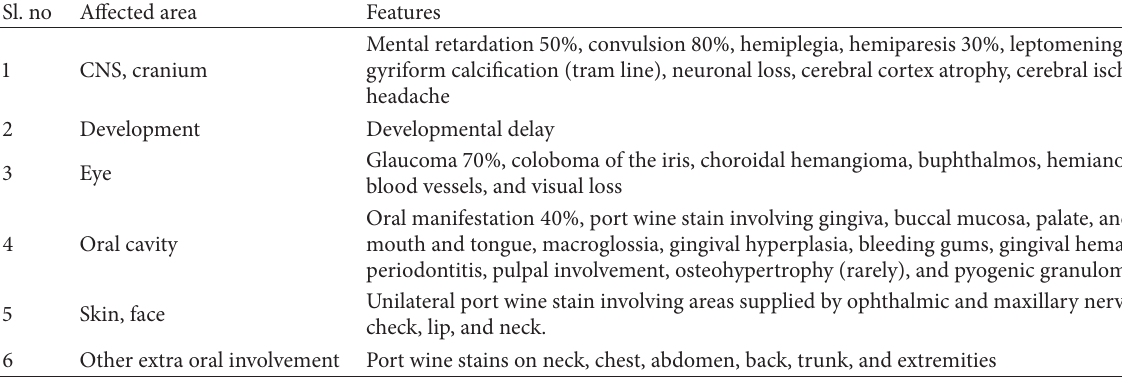
Table 1: Clinical manifestations associated with Sturge-Weber syndrome [1–3,